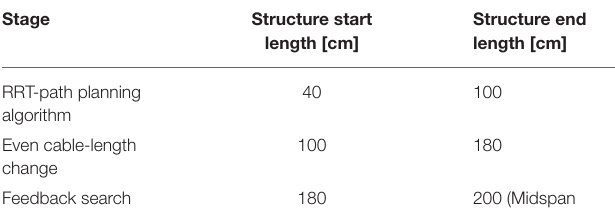
TABLE 1 | Stages of the path-planning method and corresponding structure deployment length. Stage